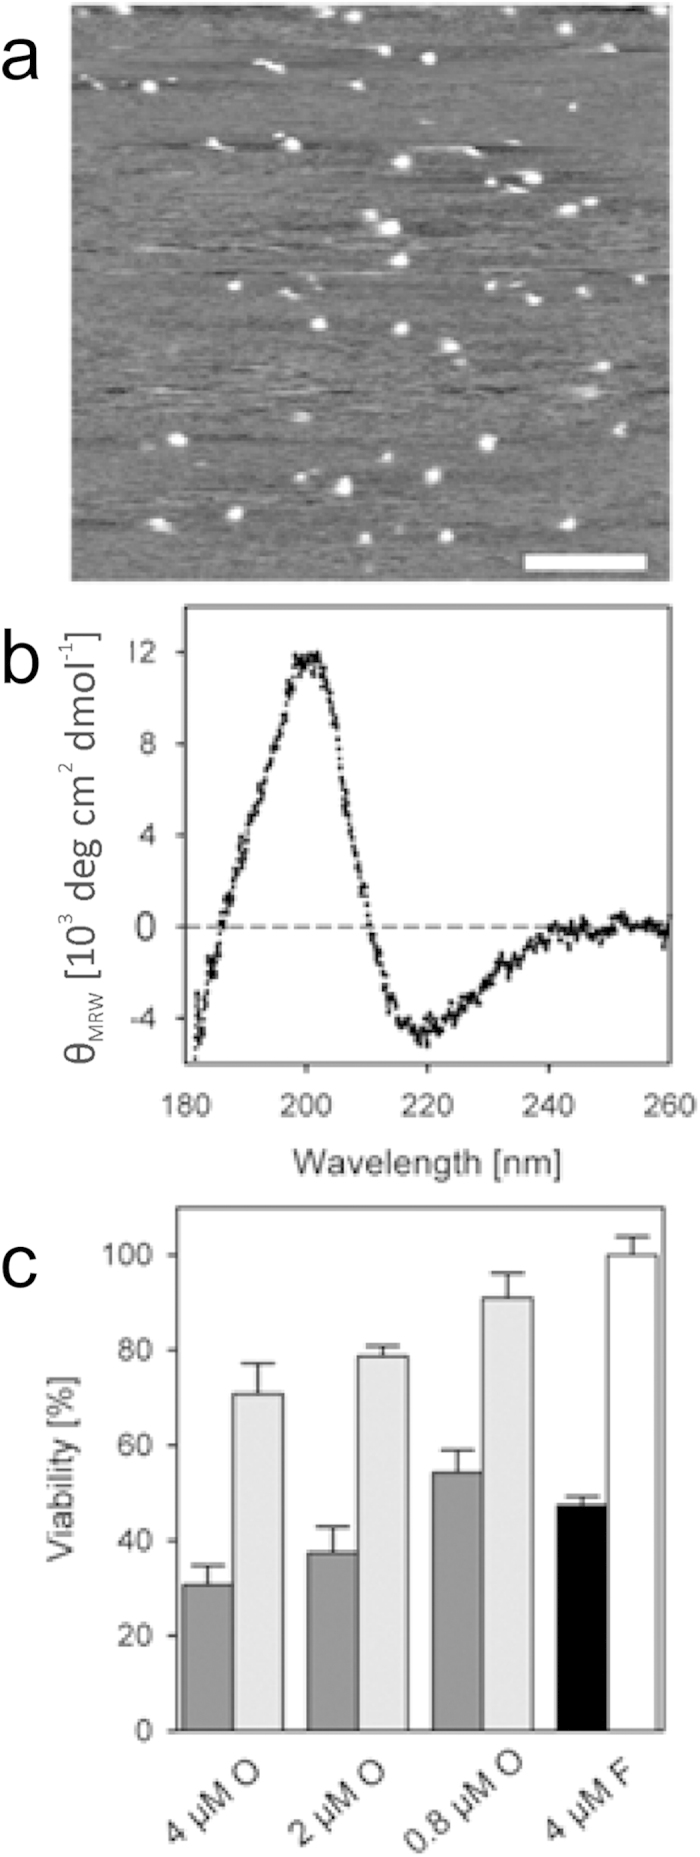
Characterization of Aβ oligomers.(a) AFM of Aβ(1–42) oligomers from pooled fractions 5 and 6. Scale bar 200 nm. (b) Far-UV CD spectroscopy of Aβ(1–42) oligomers from pooled fractions 5 and 6 indicating a pre-dominantly β-sheet secondary structure. (c) Toxicity of Aβ(1–42) oligomers from pooled fractions 5 and 6 tested by MTT cell viability. RA/BDNF differentiated SH-SY5Y cells were treated with Aβ(1–42) oligomers (dark grey) at monomer concentrations of 4, 2 and 0.8 μM with corresponding buffer dilution controls containing 16, 8 and 3.2% iodixanol (light grey), or with ultrasonicated Aβ(1–42) fibrils (black) at a monomer concentration of 4 μM and the corresponding buffer without iodixanol (white) as control. All given Aβ(1–42) assembly concentrations relate to Aβ(1–42) monomers.